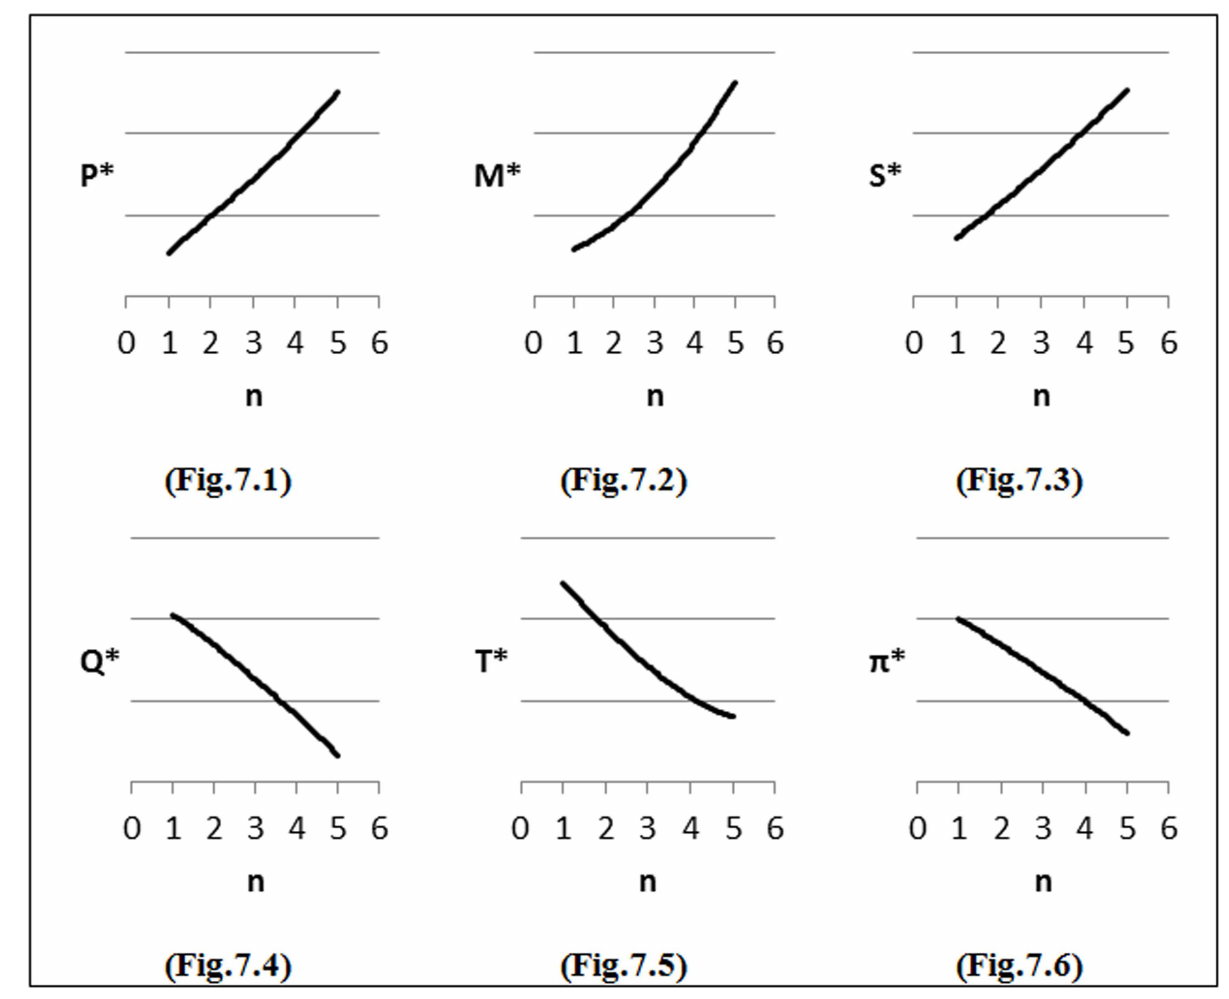
Fig 7. Effects of changes in ( θ ) on decision